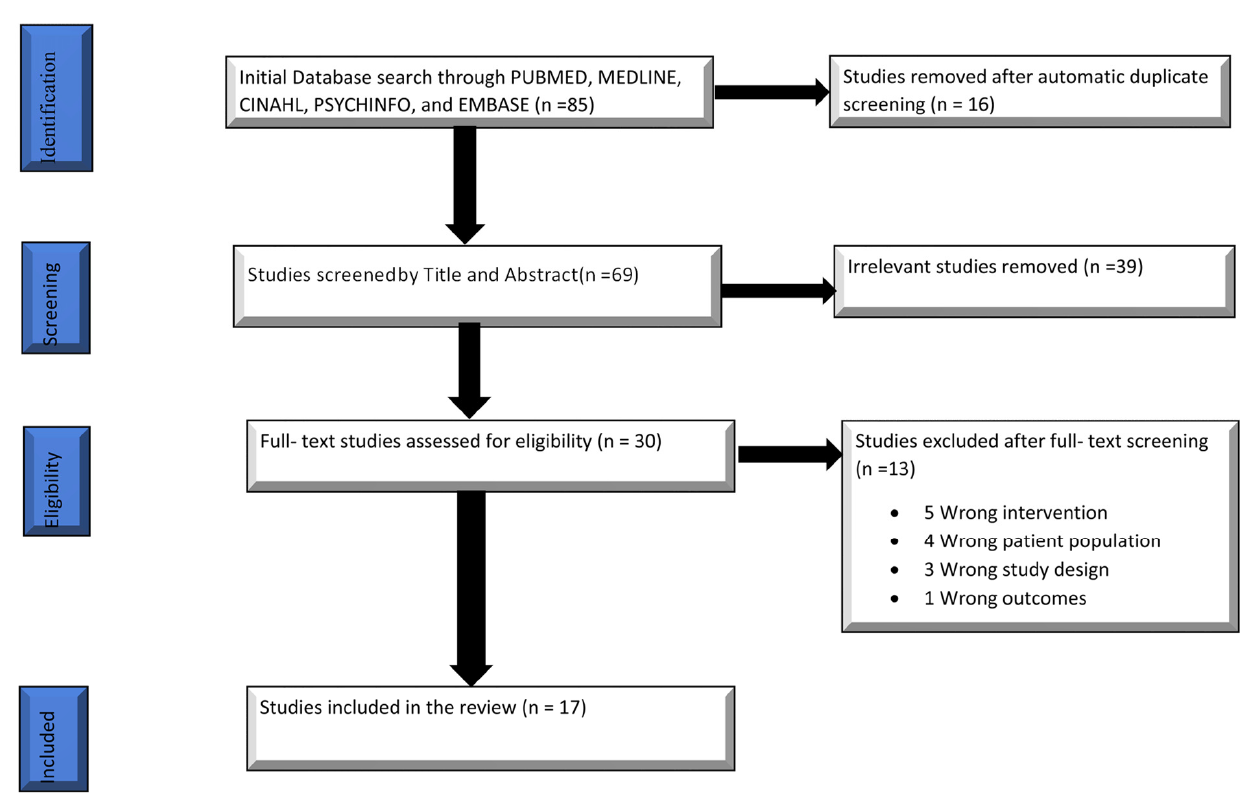
Figure 1. PRISMA flow chart describing the search results.